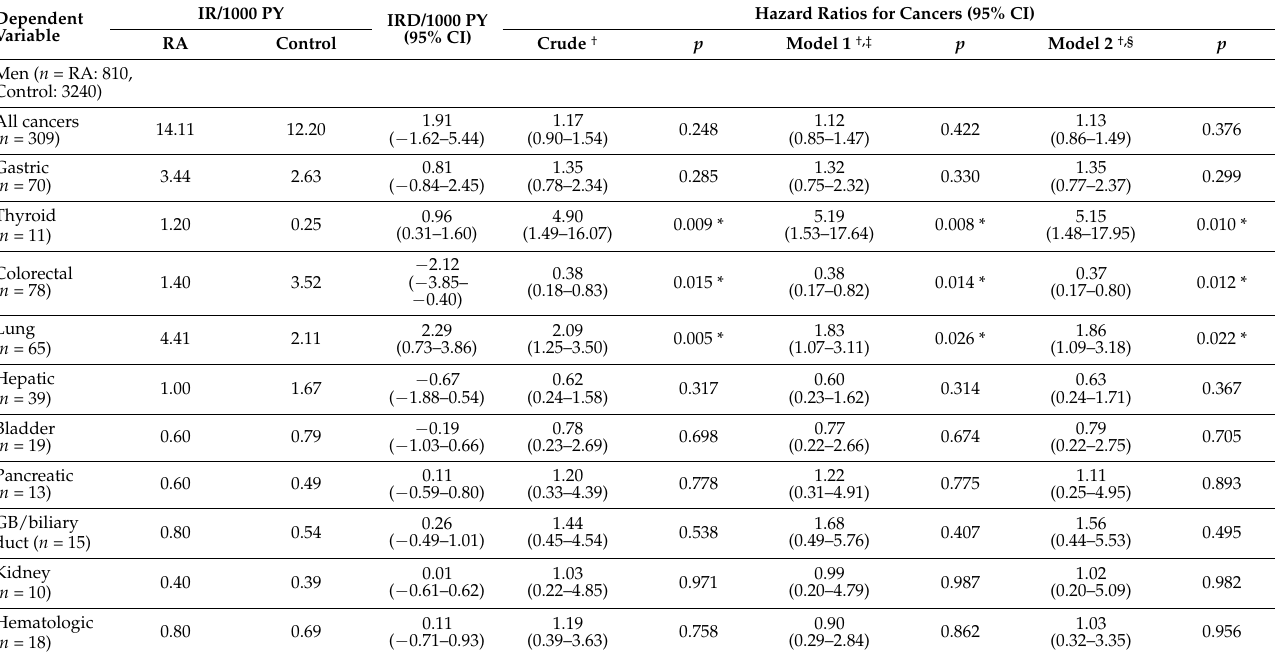
Table 3. Subgroup analysis of crude and adjusted hazard ratios of RA for various cancers by